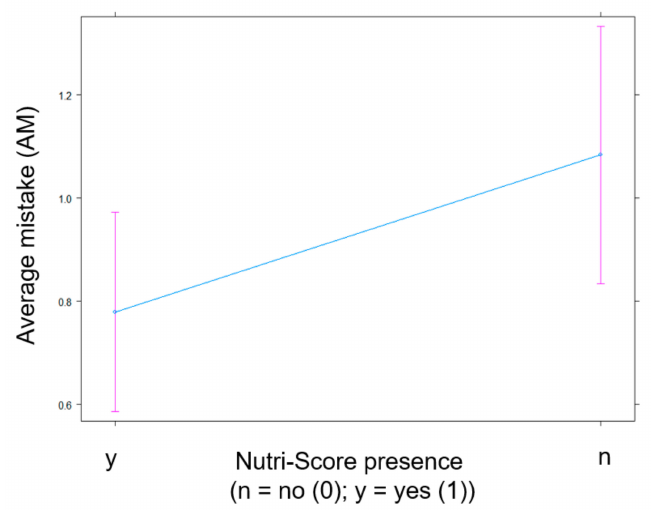
Figure 10. Impact of the presence of Nutri-Score (n = no (0); y = yes (1)) on AM in the subset of participants exposed to products with NFP.